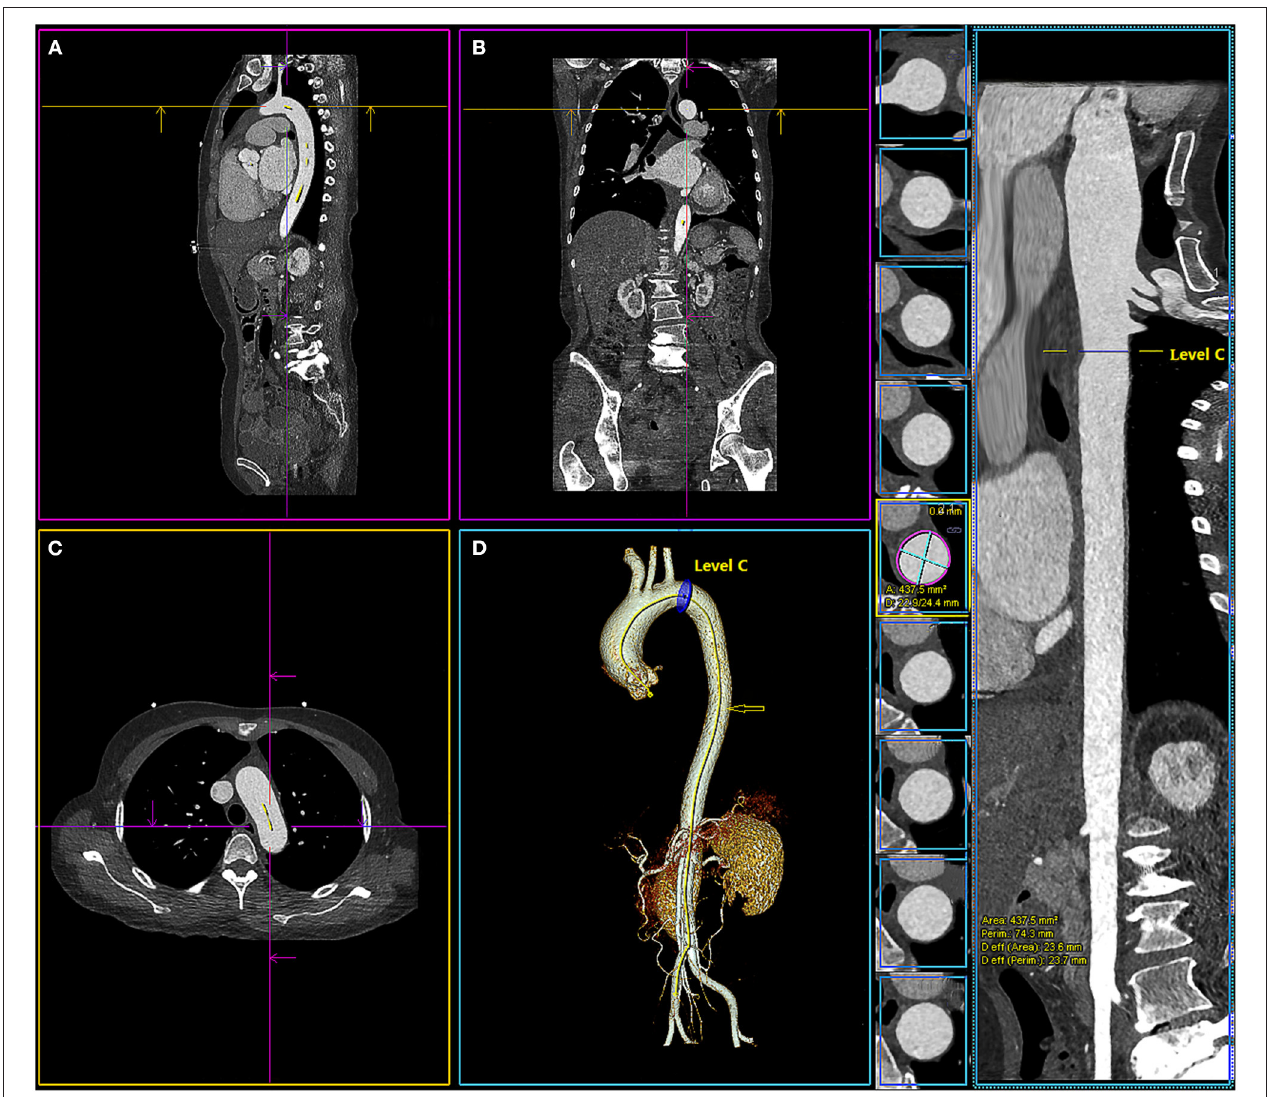
FIGURE 3 | Multiplanar views of aortic measurements in sagittal view (A) , frontal (B) , axial (C) , 3-dimensional (D) , and the centerline of the aorta ( ) with the location of level C (1cm distal to the left subclavian artery). The system calculated the maximum and minimum aortic diameter (D: 22.9/24.4mm), area (area: 437.5 mm 2 ), perimeter (perim: 74.3mm), and diameter derived from the lumen area [D eff (area): 23.6mm]